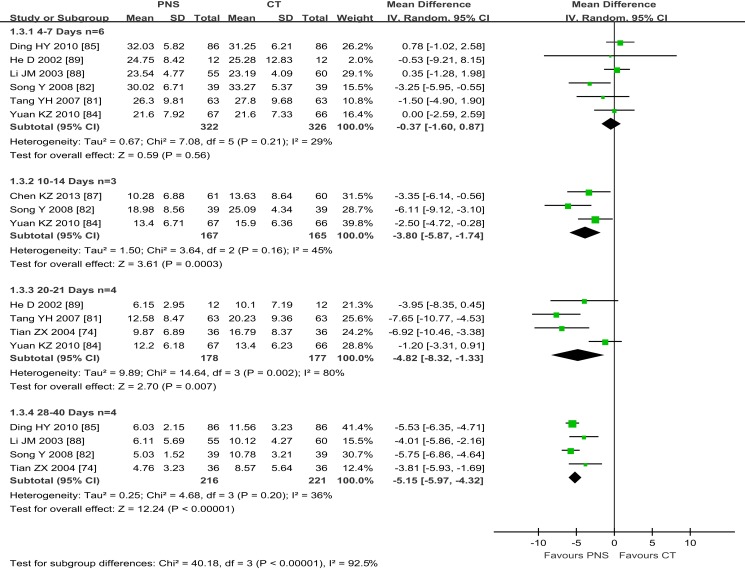
Meta-analyses of intracerebral hematoma volume (IHV) among four subgroups with different time length of PNS treatment: (1) the subtotal group of 6 trials with 4–7 days of PNS treatment (Ding HY, He D, Li JM, Song Y, Tang YH, Yuan K) and, (2) the subgroup of 3 trials with 10–14 days of treatment (Chen KZ, Song Y, Yuan KZ) showed no significant differences in IHV between PNS and CT groups; (3) the subgroup of 4 trials with 20–21 days of PNS treatment (He D, Tang YH, Yuan KZ, Tian ZX) and, (4) the subgroup of 3 trials with 28–40 days of treatment [40, 78, 108,] (Ding YH, Li JM, Song Y, Tian ZX) showed significant improvement in IHV in the PNS group than in the CT group (P<0.00001, each). PNS, Panax notoginseng saponin; CT, Current treatment.